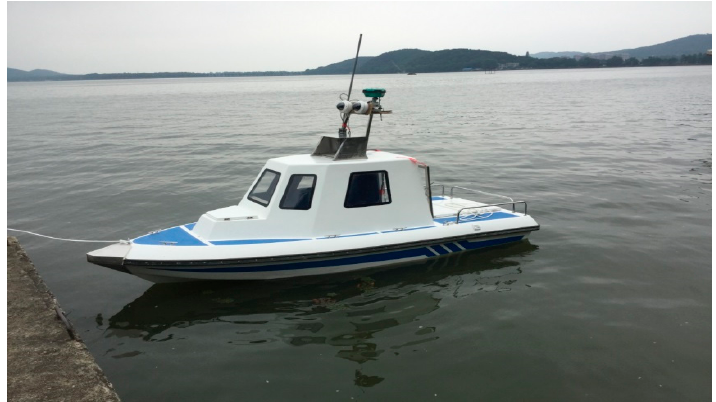
Figure 3. The experimental USV. Table 1. Parameter of the experimental USV and computer.